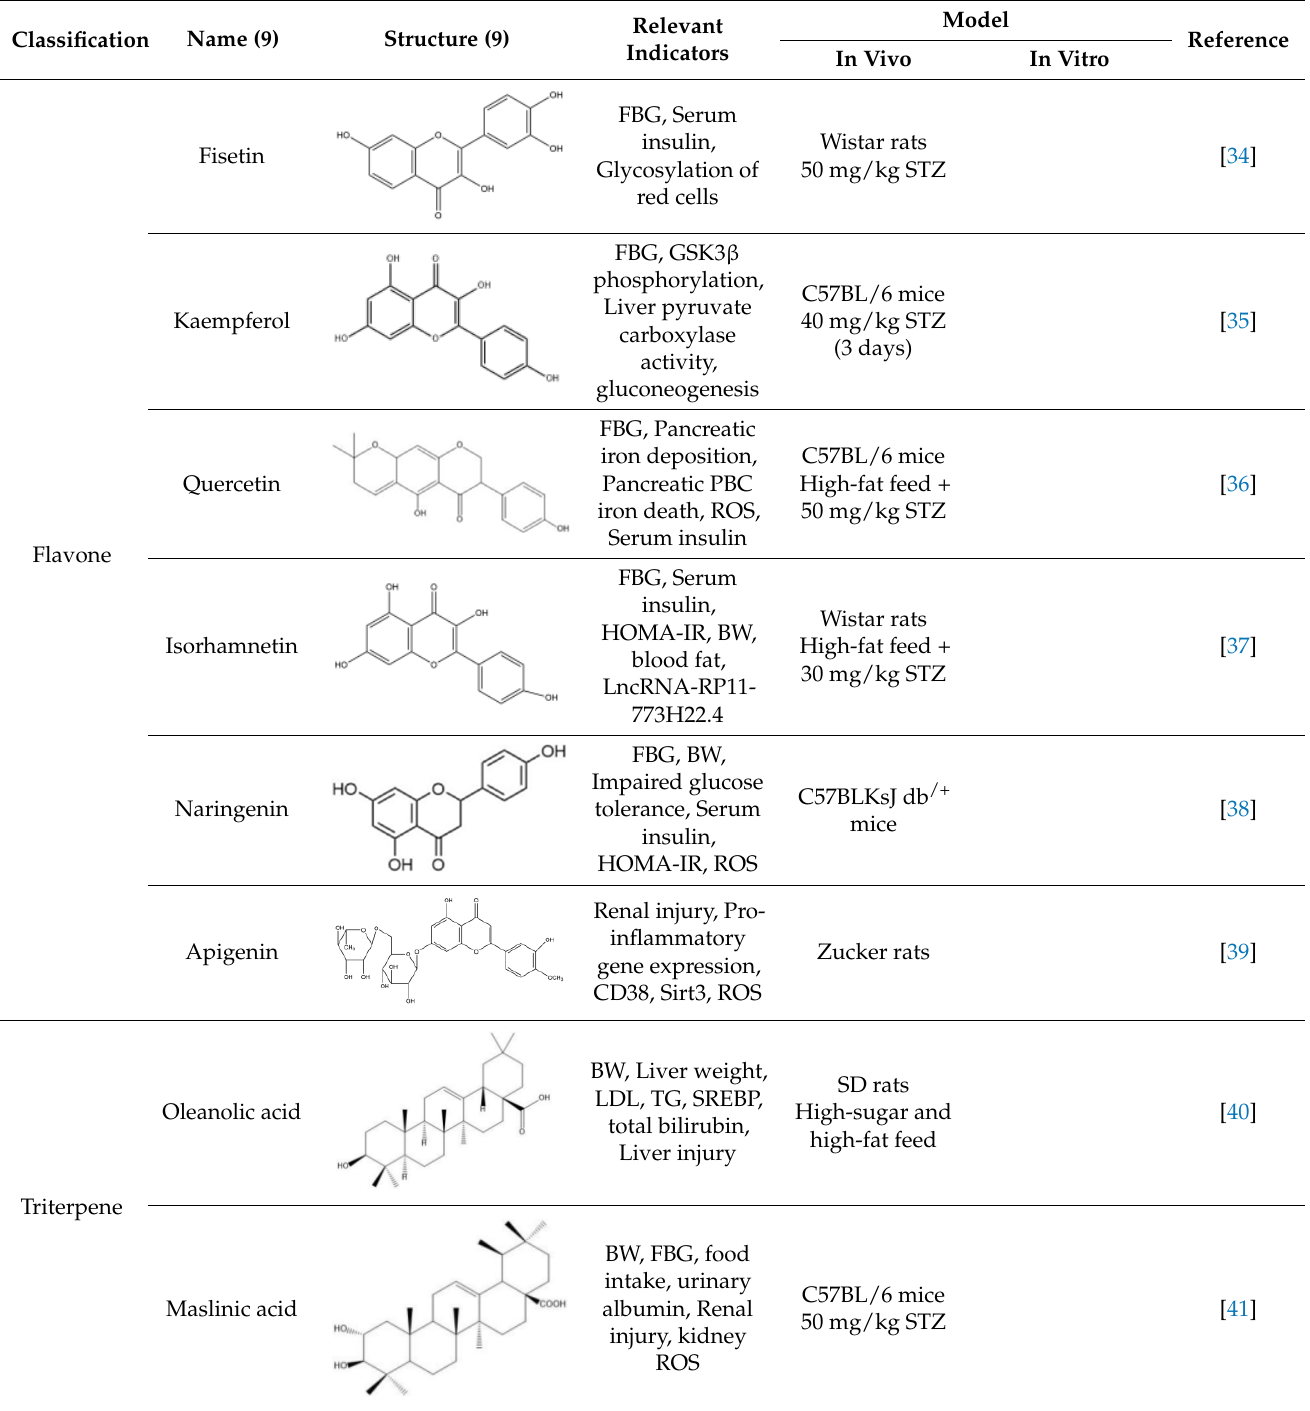
Table 2. Therapeutic effects of small molecules in Cyclocarya paliurus on type 2 diabetes mellitus.